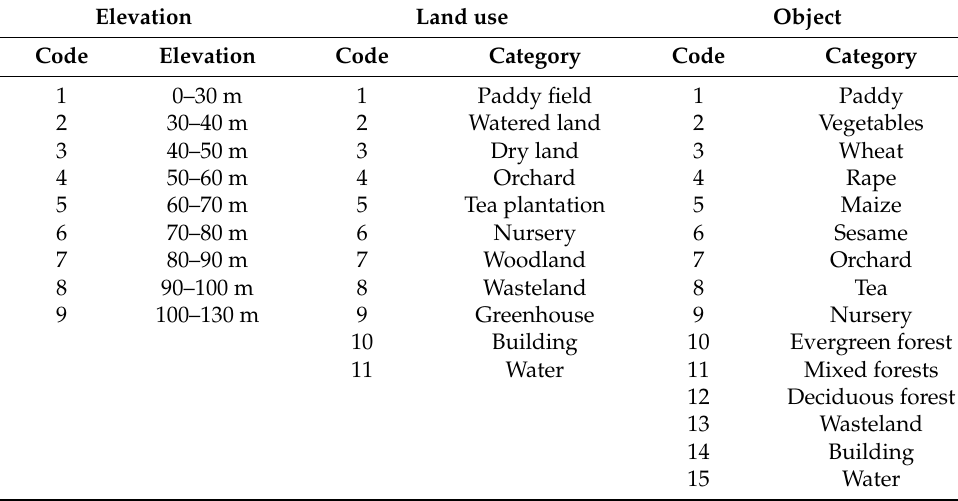
Table 4. Categories of elevation, land use, and